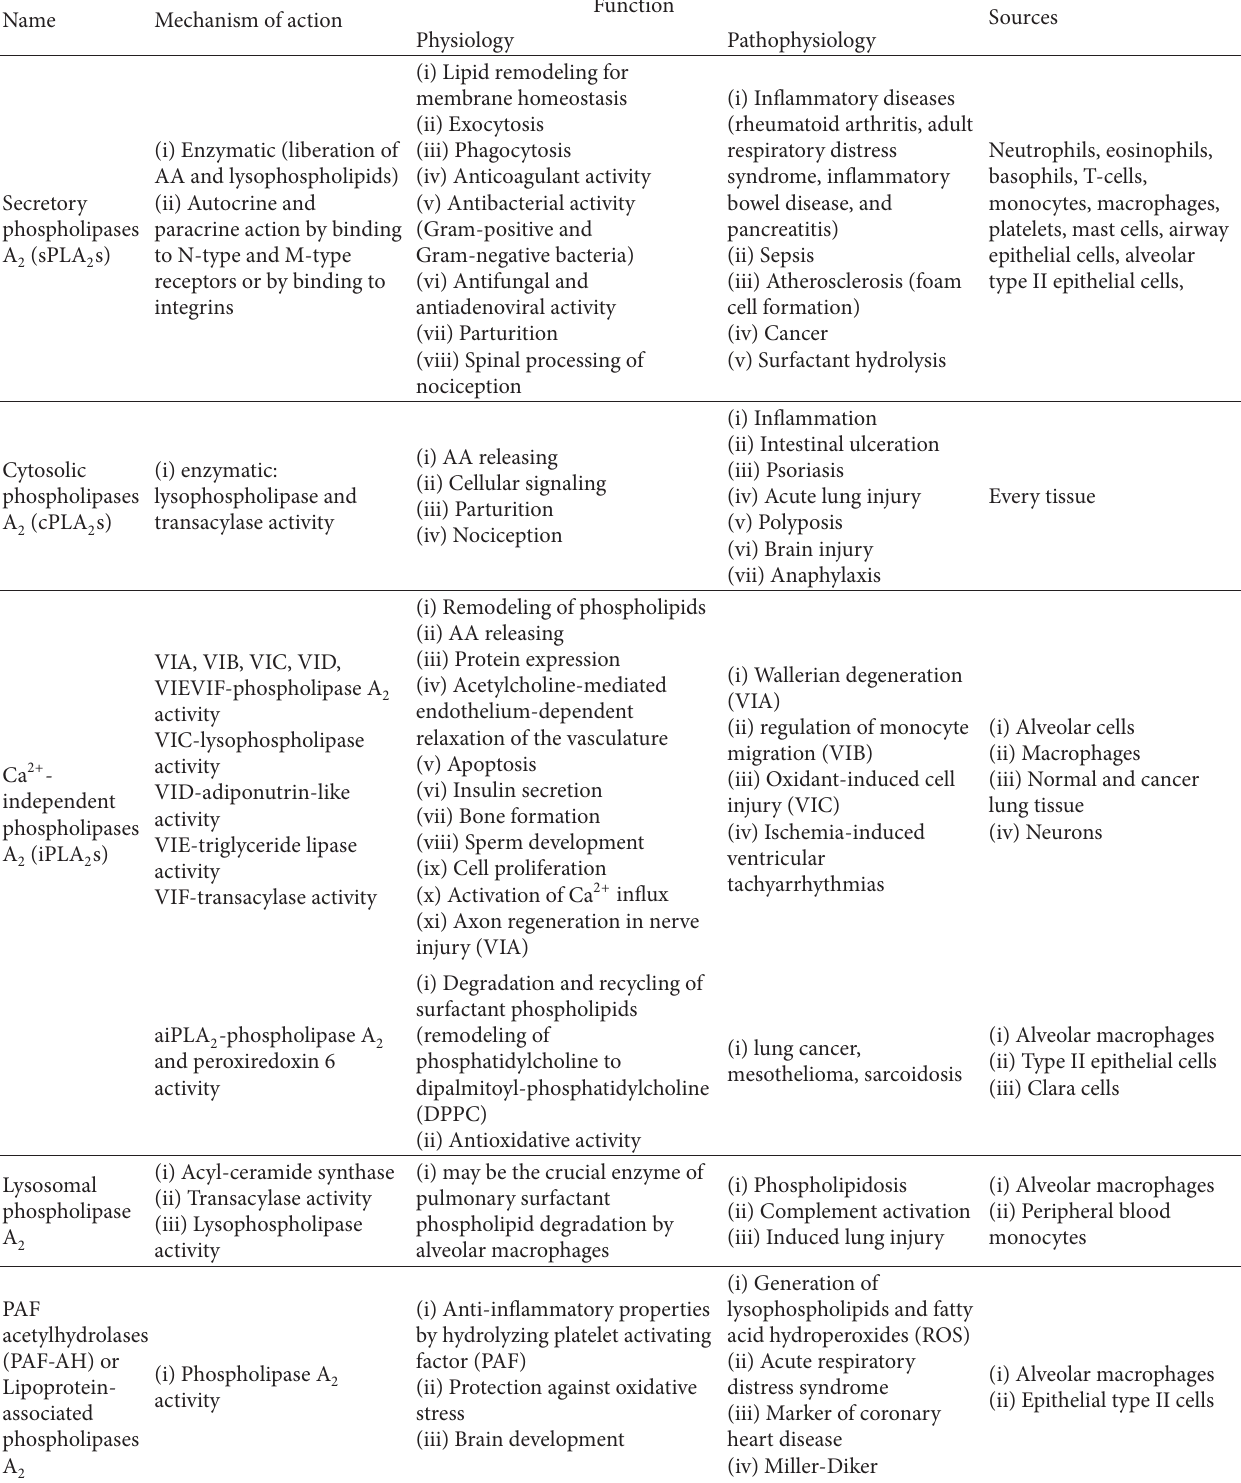
enzymes. Adapted and modified from [1, 4, 2